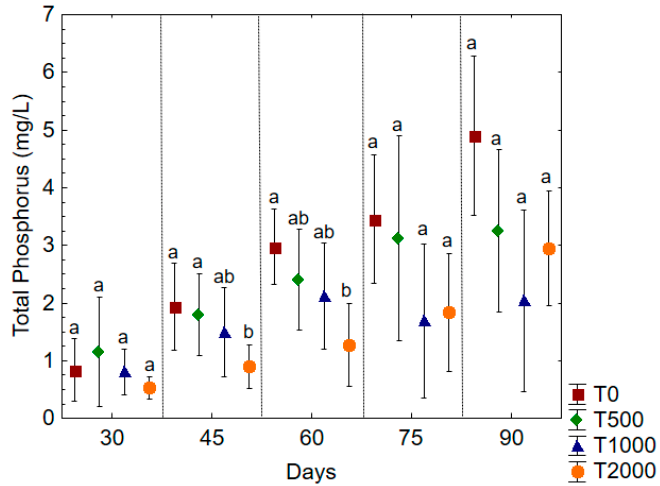
Figure 4. Mean ( ± SD) of total phosphorus throughout the experimental period of 90 days. T0: shrimp monoculture (100 shrimp/m 2 ); T500: 100 shrimp/m 2 and 500 g/m 2 of G. birdiae ; T1000: 100 shrimp/m 2 and 1000 g/m 2 of G. birdiae ; T2000: 100 shrimp/m 2 and 2000 g/m 2 of G. birdiae . Different letters indicate a significant difference between treatments according to the Tukey test ( p < 0.05).